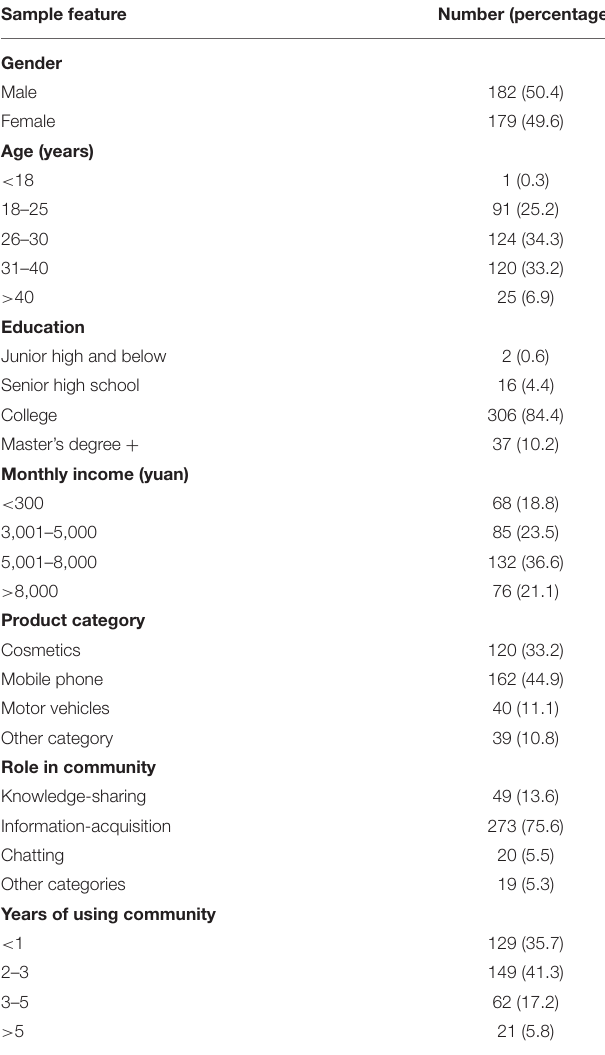
TABLE 1 | Sample basic information